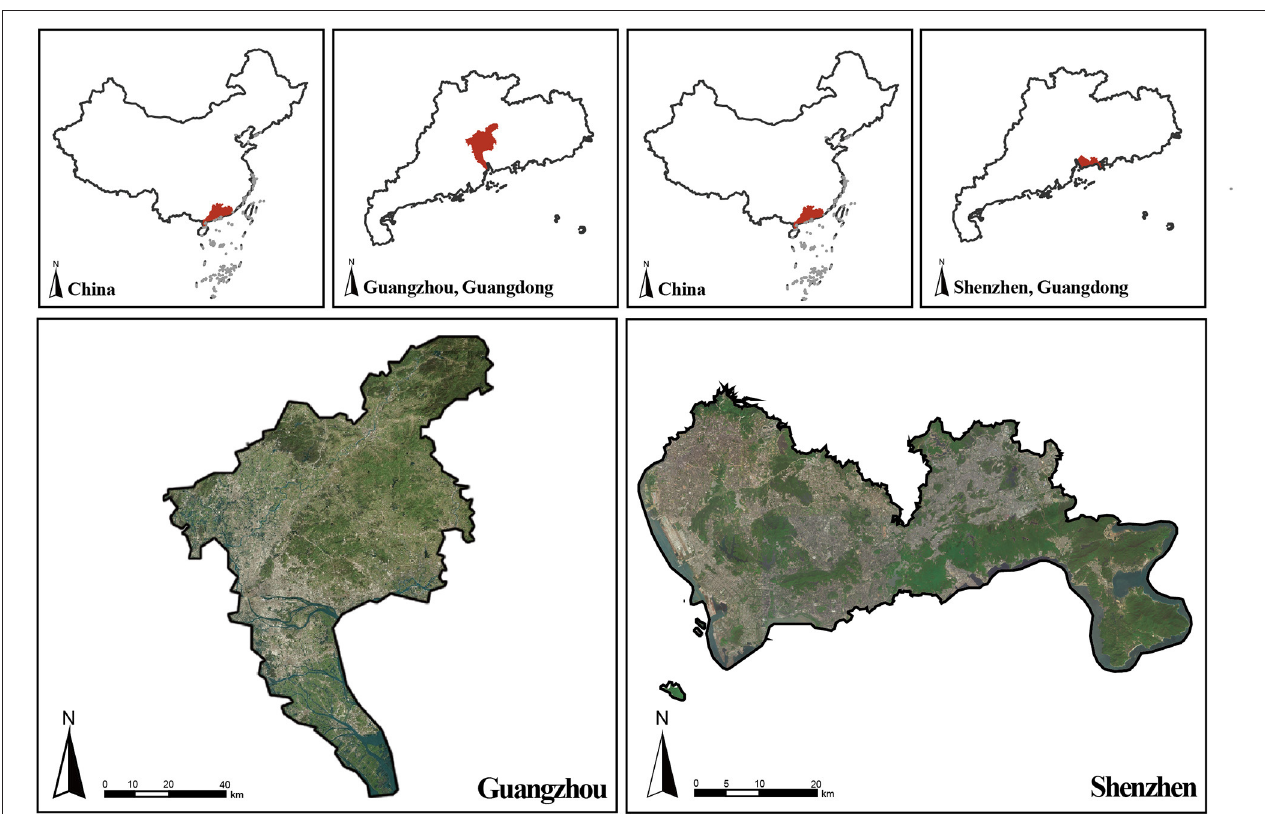
FIGURE 3 | Location of the study